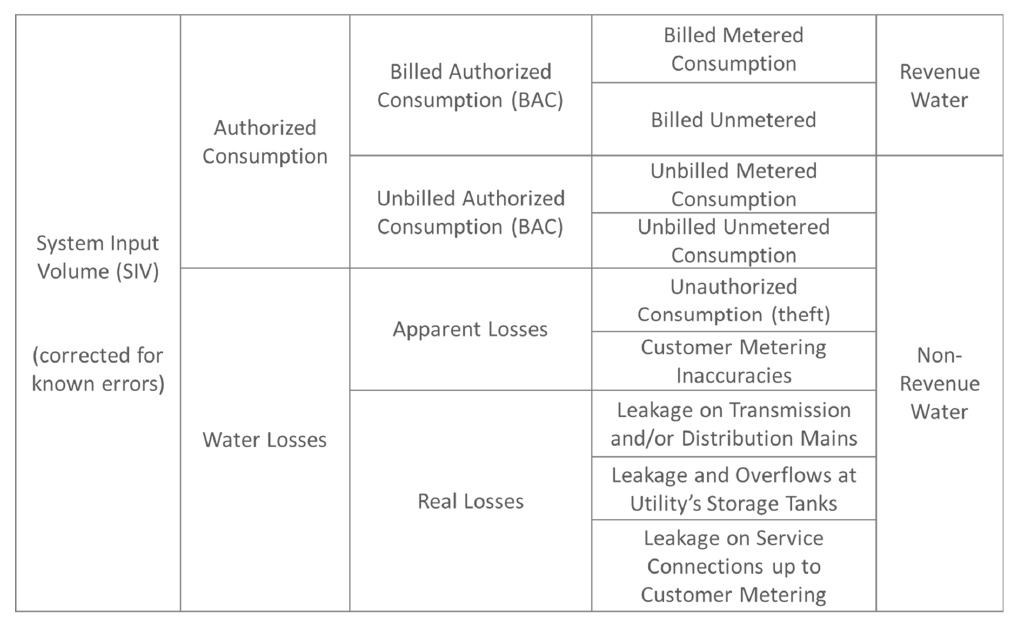
Figure 5. The International Water Association (IWA) standard SIV component analysis.